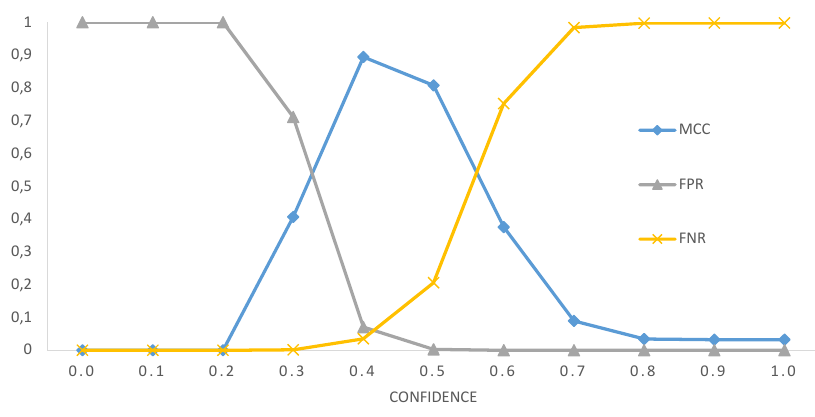
Figure 7. Performance figures of VGG2.